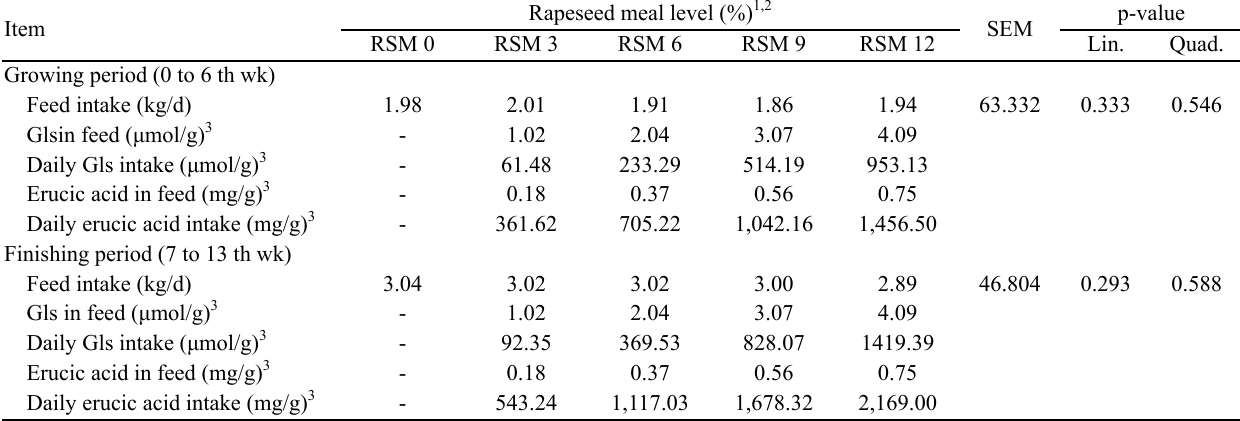
Table 6. Influence of dietary rapeseed meal (RSM) on ingested glucosinolates (Gls) and erucic acid of growing-finishing pigs